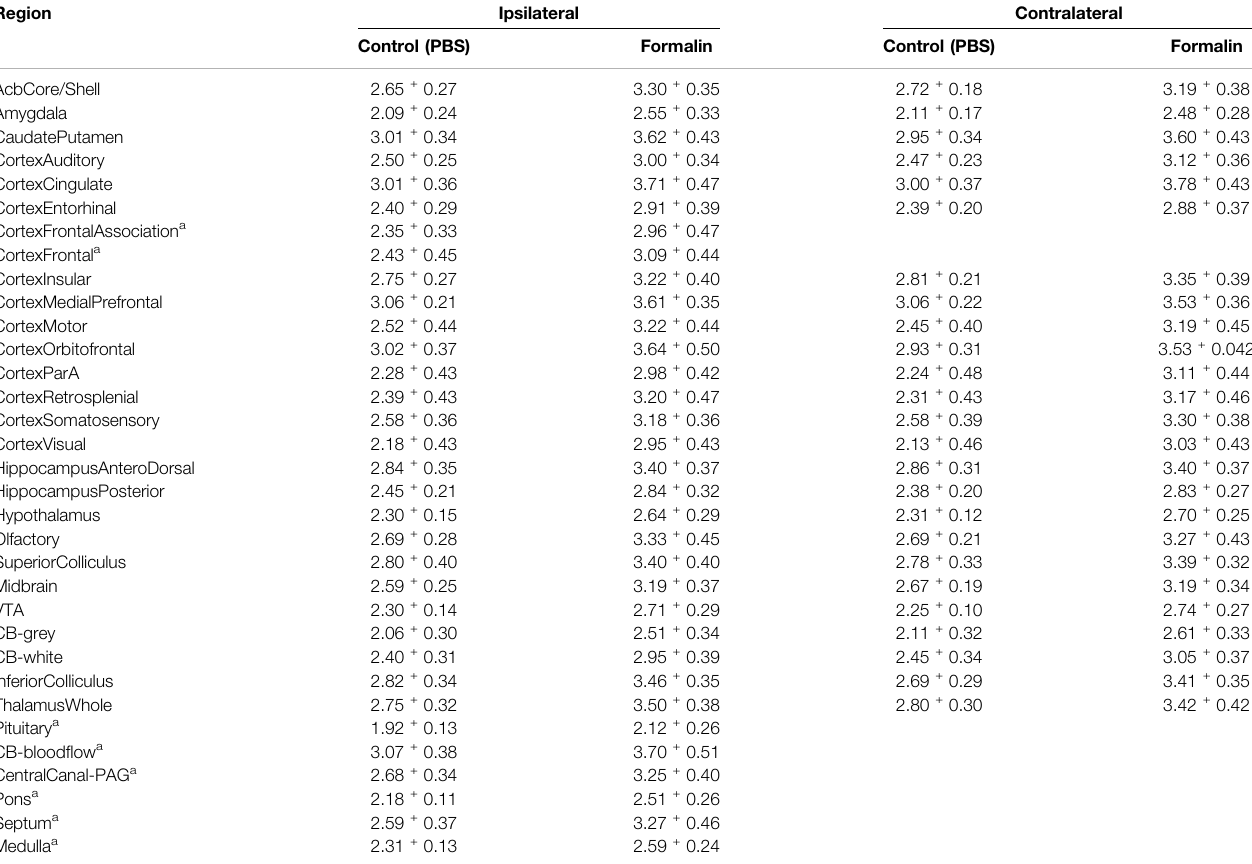
TABLE 1 | 18 F-FDG uptake in brain regions: Mean values of S. U. V.+S. E. M. Of the groups receiving PBS or formalin (i.pl.), in the two brain hemispheres. Region